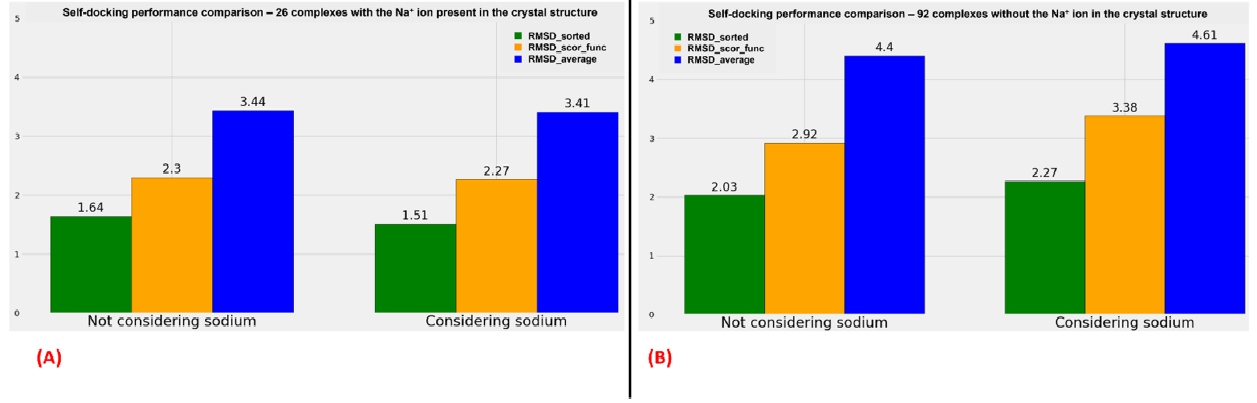
Figure 4. ( A ) Plot representing the comparison of the overall performance of the different docking algorithms implemented in this study when the sodium ion is not considered during the calculation (on the left ) and when both the sodium ion and the crystal water molecules at 4 Å or nearer to it are included (on the right ), focusing just on the 26 GPCR–antagonist complexes in which the sodium ionis already present in the crystal structure. ( B ) Graphical representation of the comparison of the overall performance of the different docking algorithms used in this study when the sodium ionis not considered during the calculation (on the left ) and when both the sodium ion and the crystal water molecules at 4 Å or nearer to it are included (on the right ), focusing just on the 92 GPCR–antagonist complexes in which the sodium ionis not present on the original crystal structure.